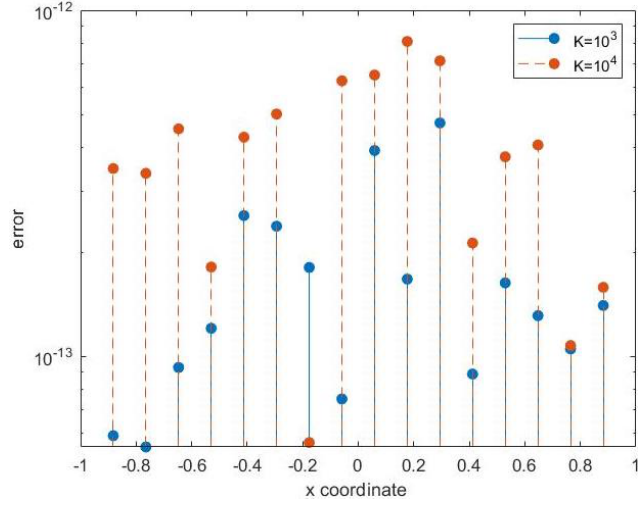
Figure 5. The absolute error for N = m = 15.